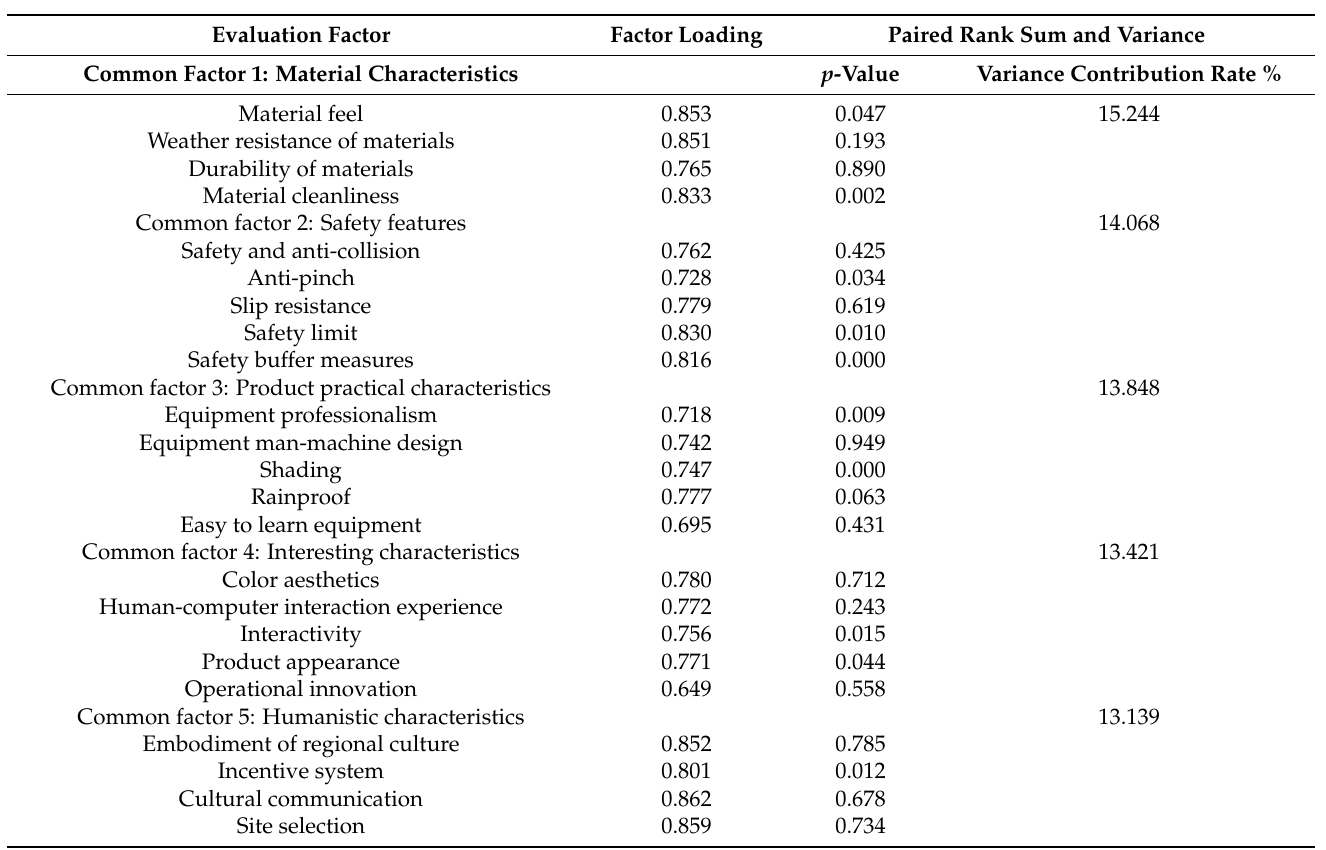
Table 2. Extraction results of satisfaction evaluation factors.